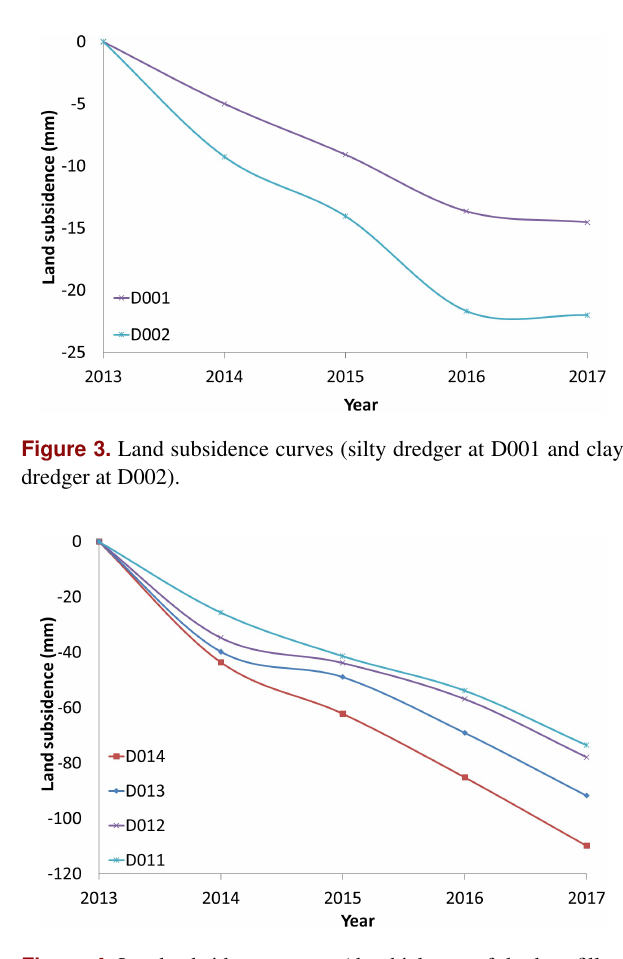
Figure 4. Land subsidence curves (the thickness of dredger fill at D014 and D013 is about 3.5m; the thickness of dredger fill at D012 and D011 is about 2.5m).